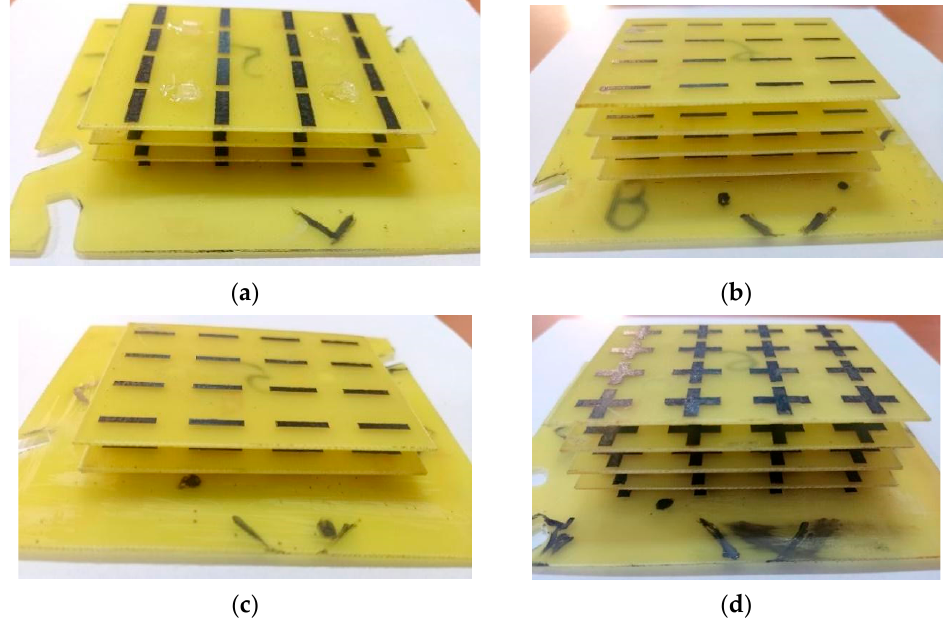
Figure 12. Fabricated FSS structures: type 5 ( a ), type 1 ( b ), type 2 ( c ) and type 8 ( d ).